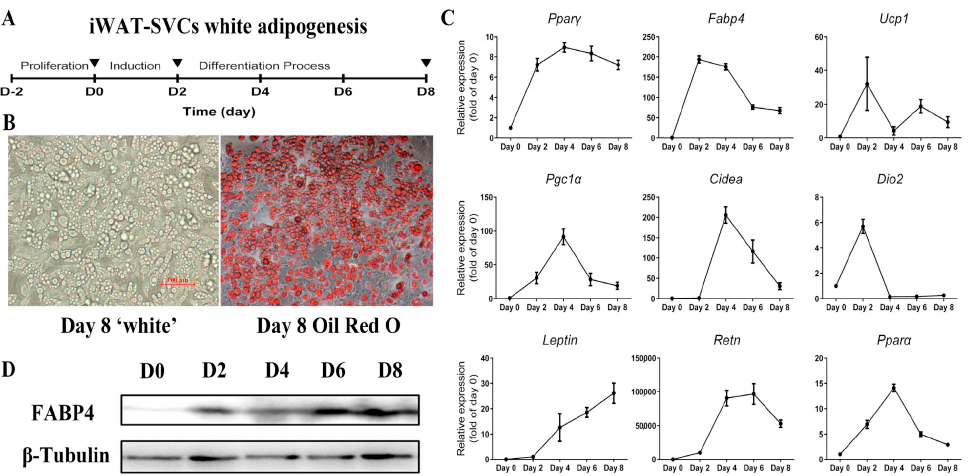
Figure 1. Gene expression profiles during mouse iWAT-SVC white adipogenesis. ( A ) Protocol used to differentiate iWAT-SVCs into white adipocytes (Day 0: add induction medium; Day 2: change medium to maintenance medium for 6 days, and change medium every 2 days; Day 8: harvest cells for Oil Red O staining); ( B ) Fully differentiated adipocytes at Day 8 and Oil Red O staining of cells differentiated at Day 8, respectively; ( C ) qPCR analysis of adipogenic genes ( Ppar γ and Fabp4 ), brown-selective genes ( Ucp1 , Pgc1 α , Cidea , and Dio2 ) and white-selective genes ( Leptin and Resistin ); ( D ) Western blot analyses of adipocyte marker FABP4 in differentiated cells. * p < 0.05, ** p < 0.01. qPCR data were normalized to Day 0 and represented as Mean ±